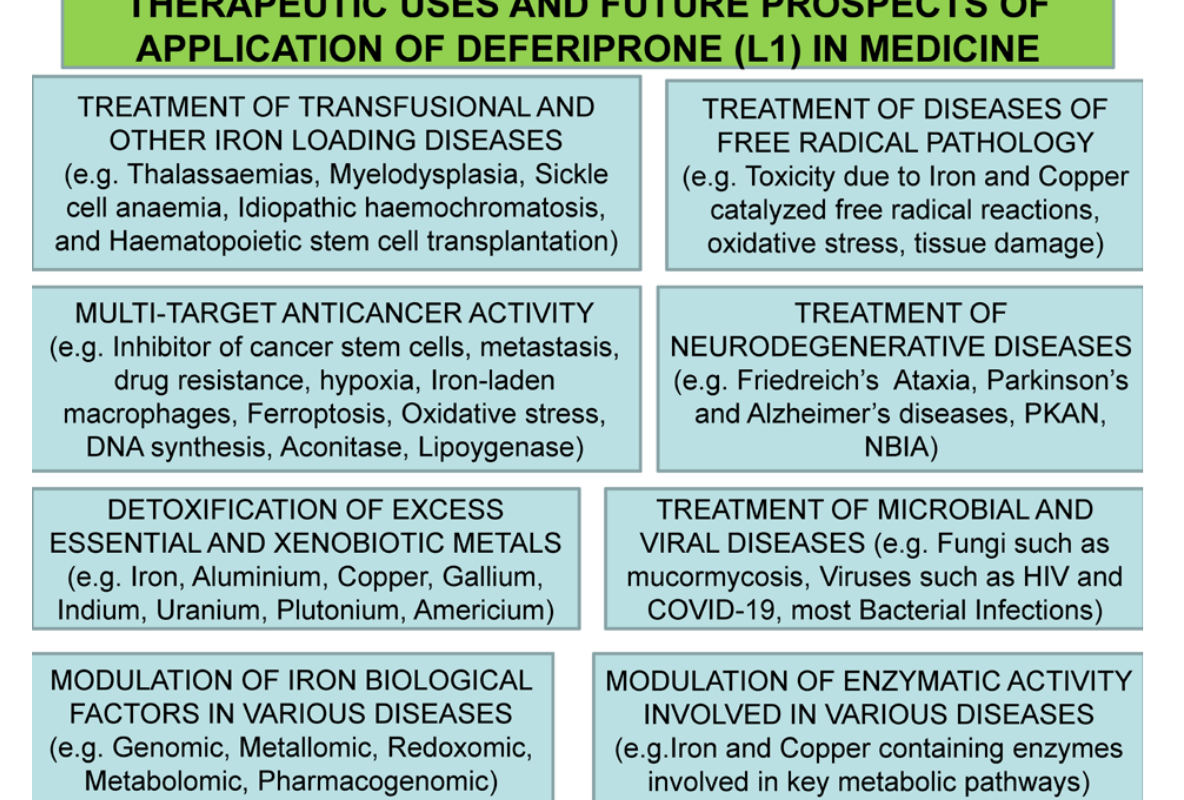
Figure 8. Ongoing therapeutic uses and future investigations of deferiprone (L1) in medicine. Deferiprone (L1) is widely used in the treatment of iron overload worldwide and also other conditions where the present treatments appear to be ineffective. The wide range of therapeutic application prospects is related to its safety profile and also the access and distribution in almost all organs at therapeutic concentrations. PKAN: pantothenate-kinase-associated neurodegeneration; NBIA: neurodegeneration with brain iron accumulation.